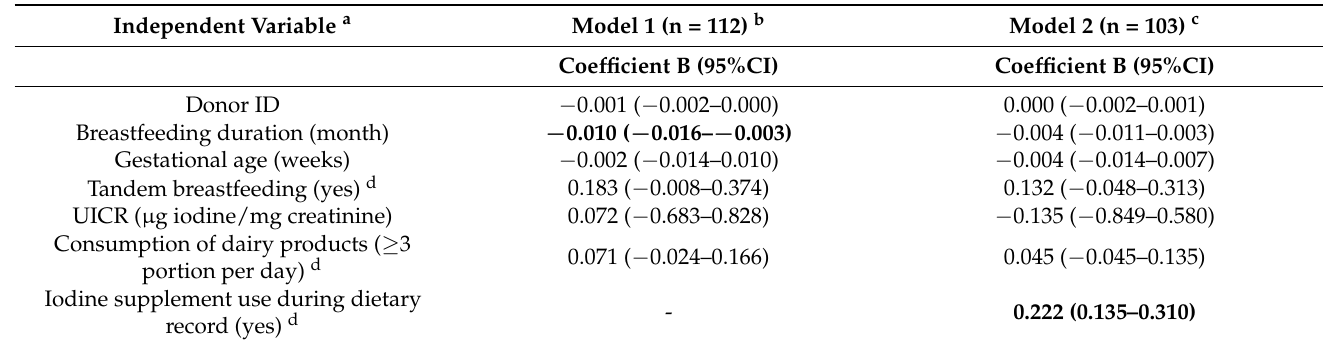
Table 6. Coefficient B (95% CI) for donor human milk iodine concentration (DHMIC) by covariates (multivariate analysis).